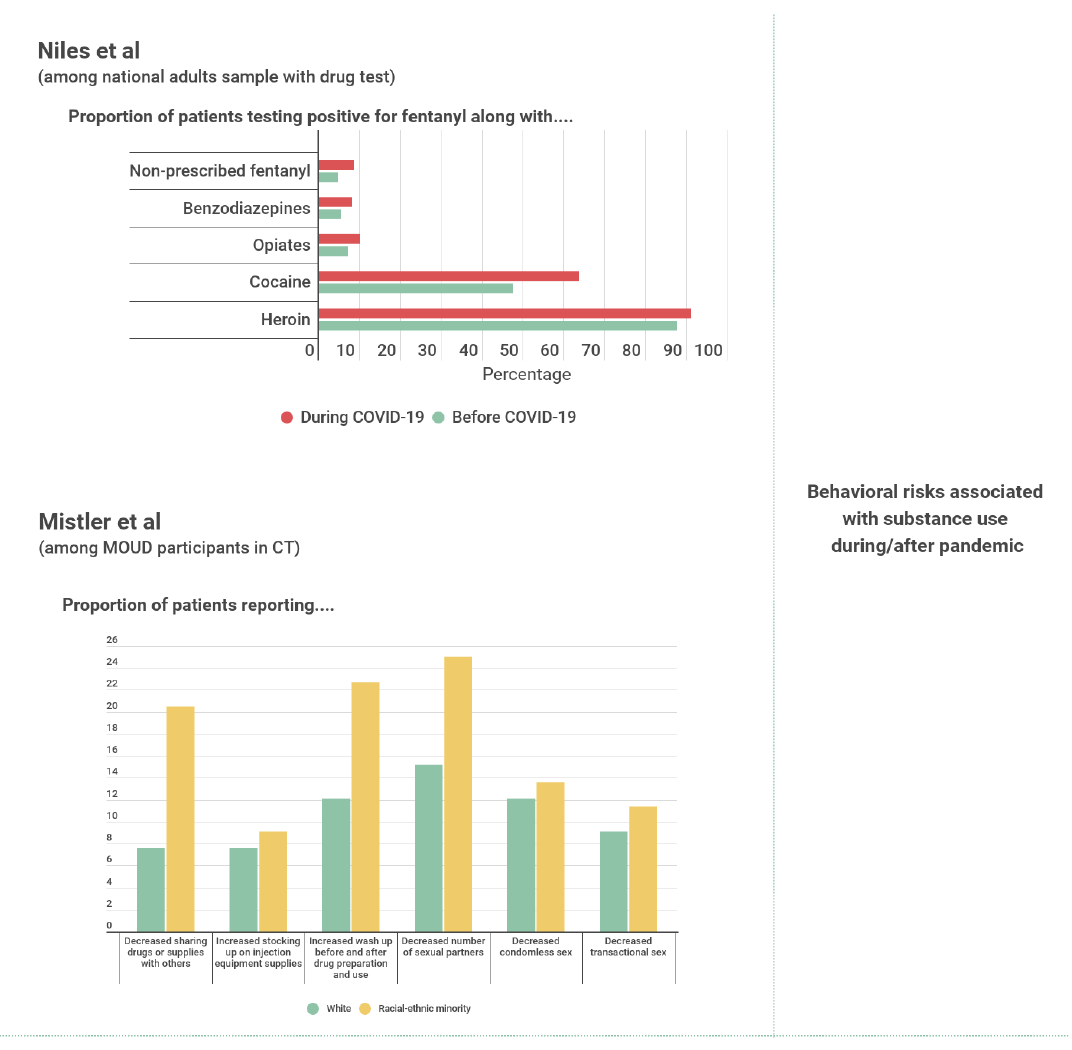
Figure 4. Summary evidence for changes in illicit substance use contexts and behaviors. MOUD= Medications for Opioid Use Disorders. CT= Connecticut [26,33].